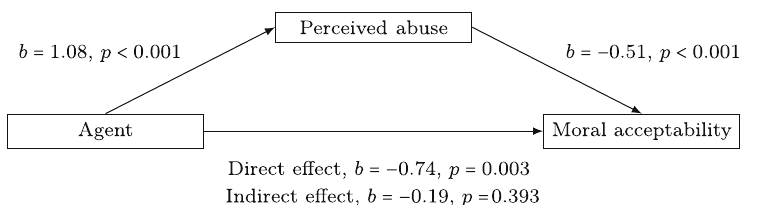
Figure 4: Mediation model showing the full mediation by perceived video on the relationship between agent and moral acceptability of reactive aggression. Note that the default for agent was set at human , so that reactive aggression was seen as less acceptable and more abusive for the robotic